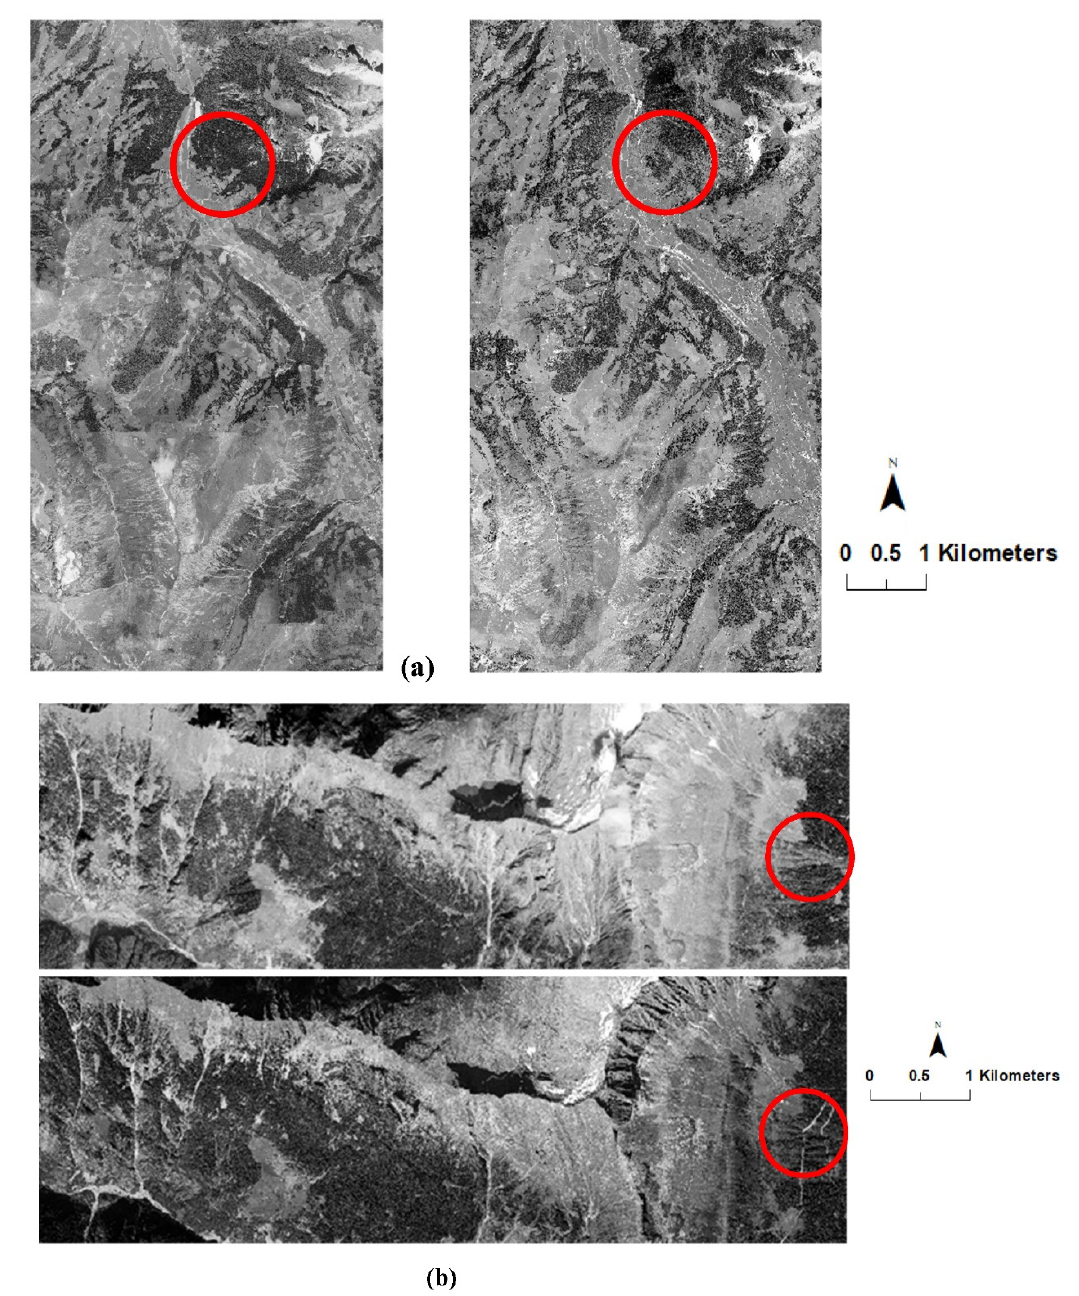
Figure 2. ( a ) B&W aerial images (left: Img_T1 from 1980, right: Img_T2 from 2010) of study area 1 in the Bernese Oberland (center coordinates 7°23 ′ 43 ″ E, 46°29 ′ 20 ″ N). ( b ) B&W aerial images (top panel: Img_T1 from 1980, bottom panel: Img_T2 from 2009) of study area 2 in the Southern Alps (center coordinates 9°4 ′ 11 ″ E, 46°23 ′ 21 ″ N). The red circles show an example of the change in the treeline ecotone between the two time points © swisstopo.